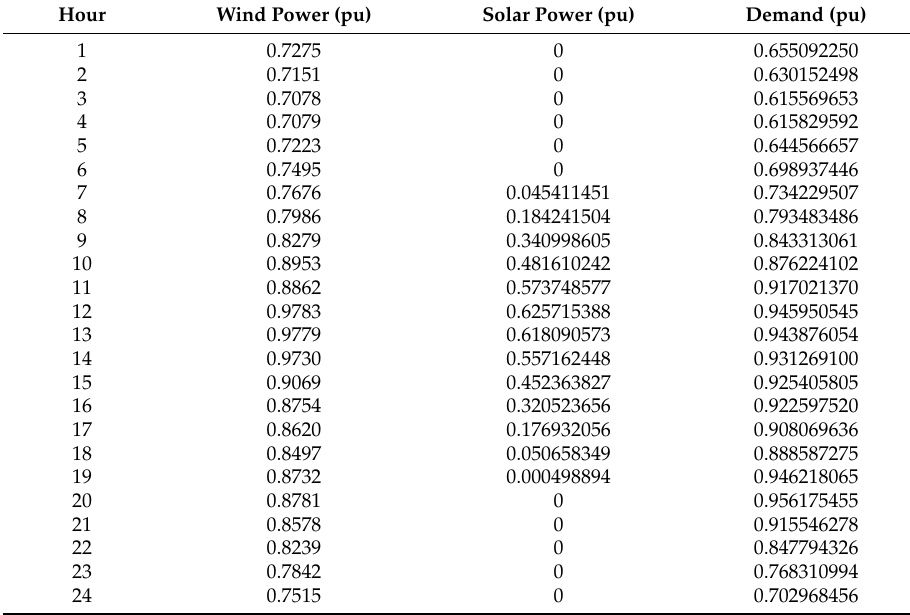
Table 6. Renewable and demand generation curves.